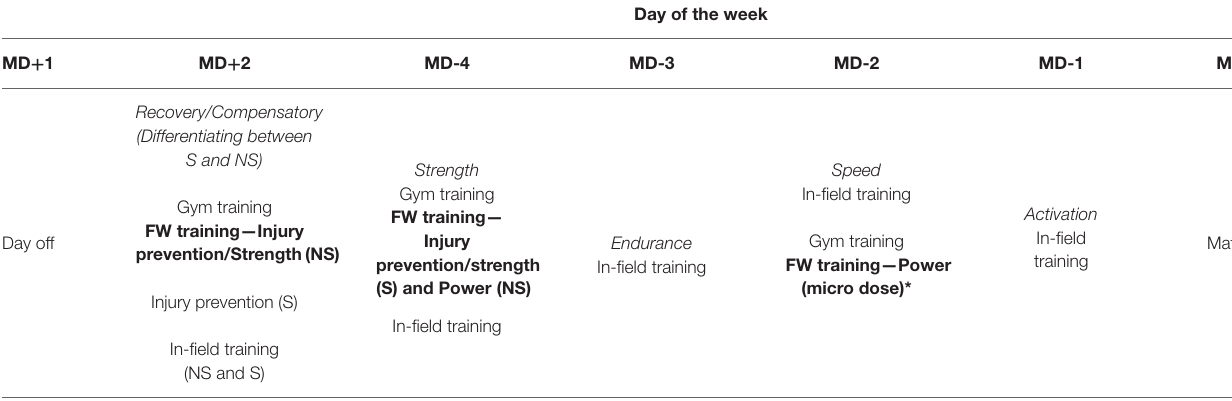
TABLE 1B | In-season weekly program for a professional soccer team (one match per week).